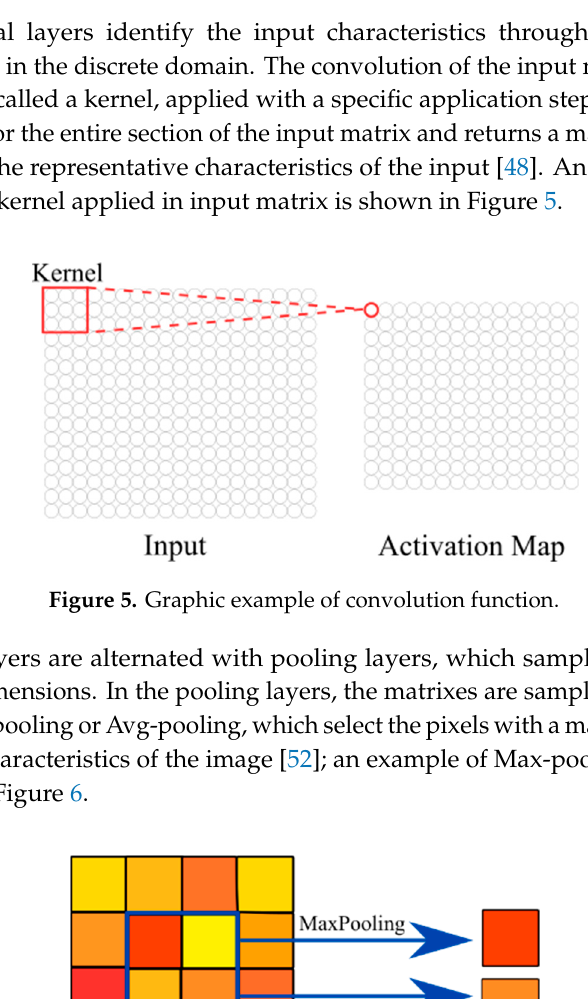
Figure 4. Structure of the convolutional neural network (CNN).